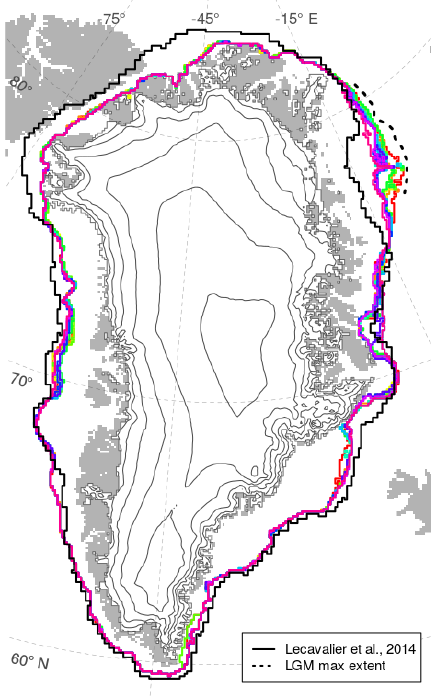
Figure 7. Simulated GrIS extent during the LGM for differ- ent oceanic forcings compared to other glacial reconstructions. Coloured lines follow the colour scale of Fig. 3. The solid black line refers to the maximum glacial extent simulated by Lecavalier et al. (2014), calibrated to match the minimum LGM configuration (Funder et al., 2011) in the north-east. The dashed black line repre- sents the expected maximum glacial extent in the north-east sector as inferred from various geological data (Arndt et al., 2015, 2017; Evans et al., 2009; Winkelmann et al.,